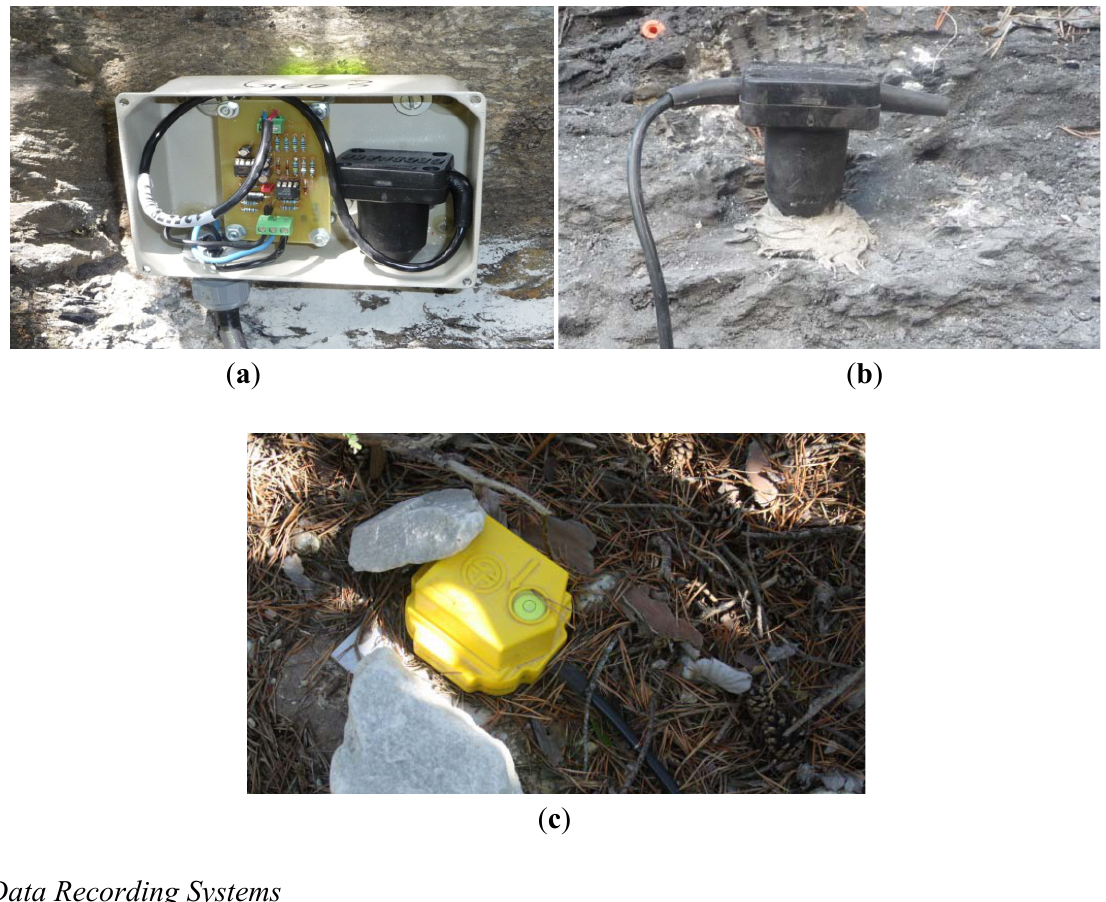
Figure 2. Factors affecting the ground vibration signal: assembly of sensors: ( a ) geophone fixed inside a metal sheet box (a signal conditioner can also be seen in the box), ( b ) fixed directly on the bedrock, and, ( c ) nailed down in the soil. Normally the geophone is additionally protected from the rainfall or